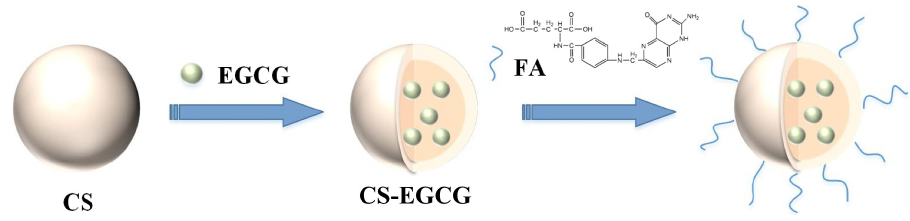
Fig. 1. Schematic of CS-EGCG nanoparticle and FA-CS-EGCG preparation.